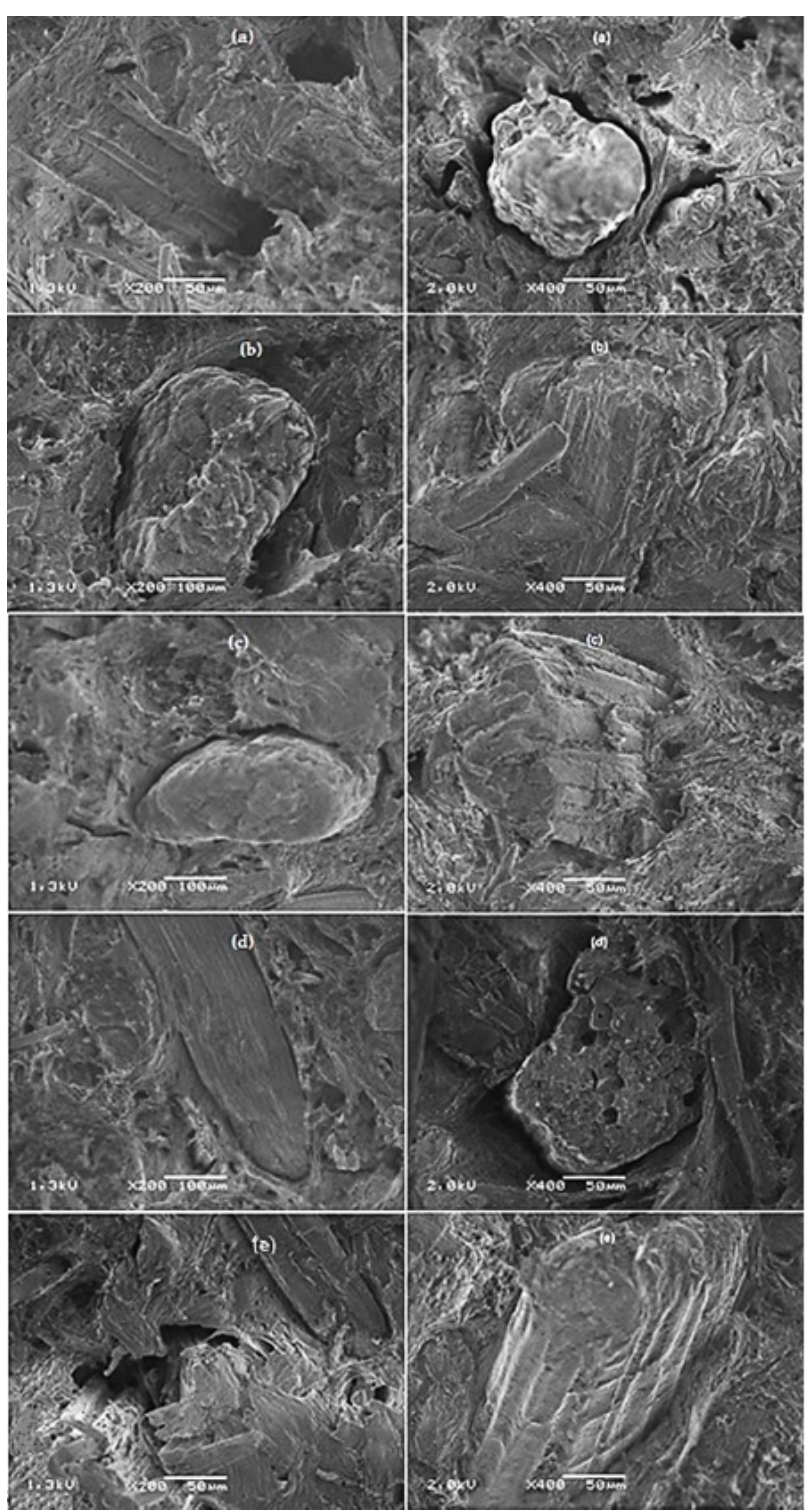
Figure 6. SEM micrographs of the fracture surface after the tensile test: ( a ) BF/PP X200 and X400; ( b ) BF/PP/MAPP X200 and X400; ( c ) BF/PP/TRIA X200 and X400; ( d ) BF/PP/DODA X200 and X400; ( e ) BF/PP/HEXA X200 and X400.